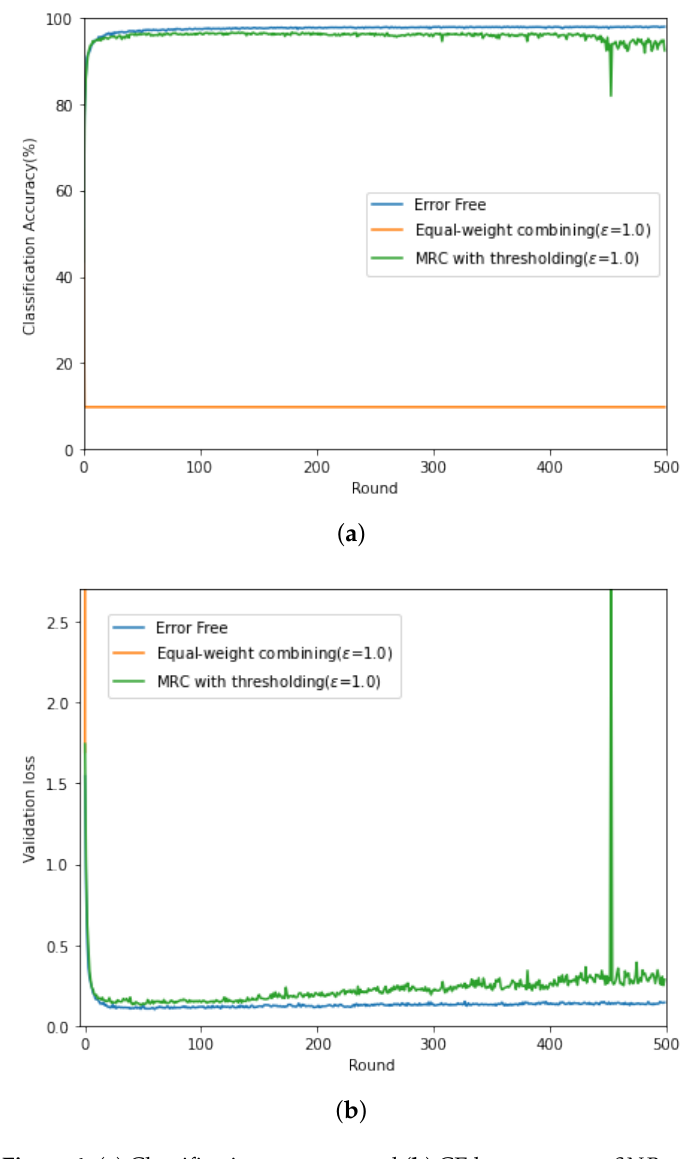
Figure 4. ( a ) Classification accuracy and ( b ) CE loss curves at SNR rec = − 10